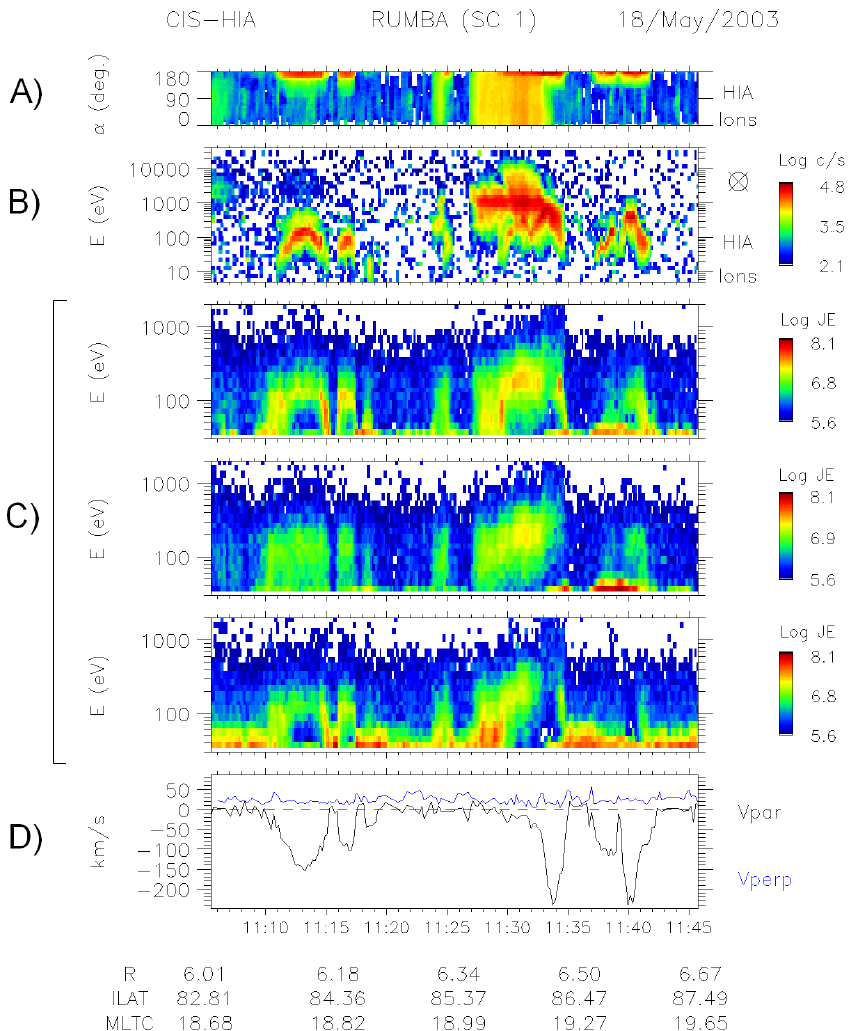
Fig. 11. 18 May 2003. (A) Pitch-angle distribution from HIA for all ions. (B) Energy-time spectrogram from HIA for all ions. (C) Energy- time spectrogram from PEACE. From top to bottom: downgoing electrons, electrons perpendicular to the magnetic field and upgoing electrons. (D) Ion perpendicular velocity (blue) and parallel velocity (black) computed from HIA.